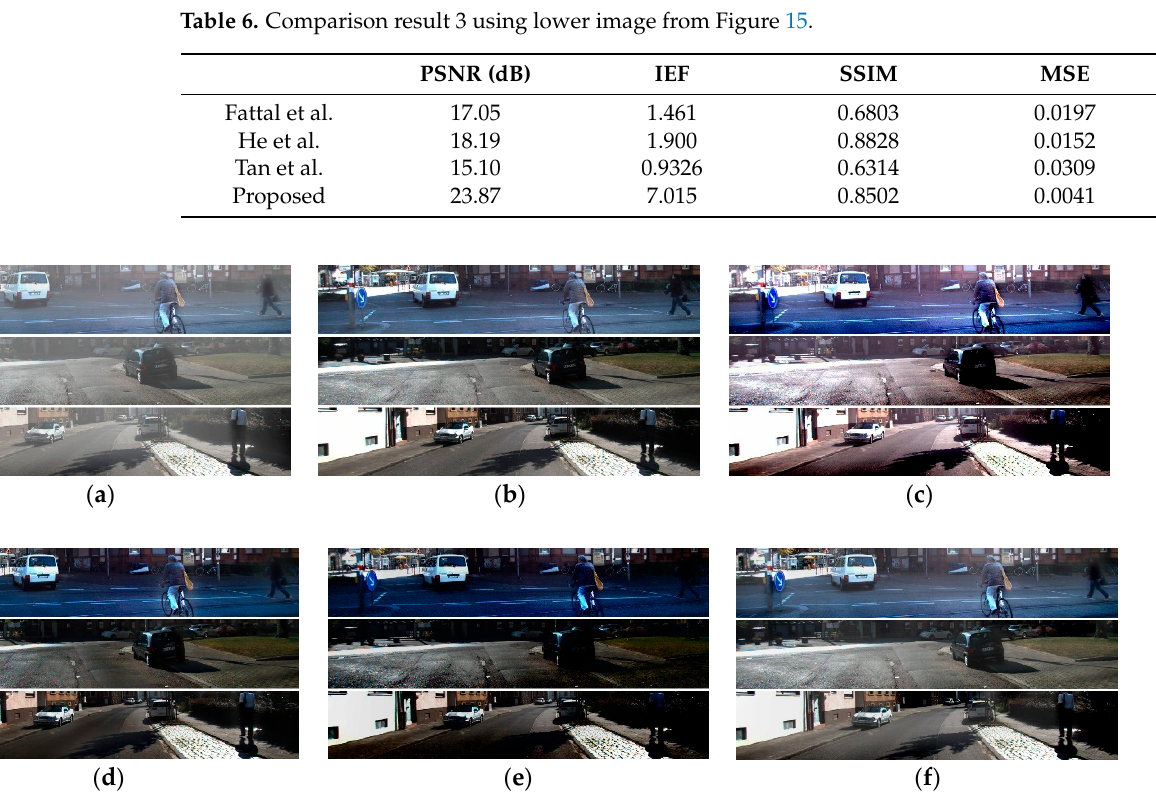
Table 3. Quantitative analysis of improvement using third row image from Figure 14.